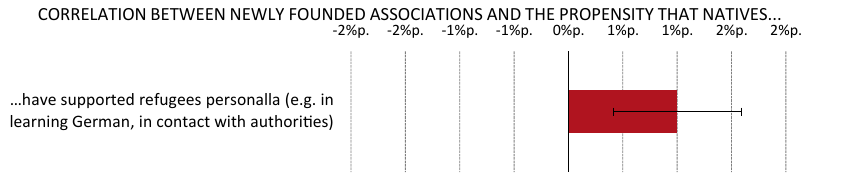
Figure 3: Relationship between newly founded associations and actual civic engagement towards refugees. Source: SOEP 2016 and 2018, own